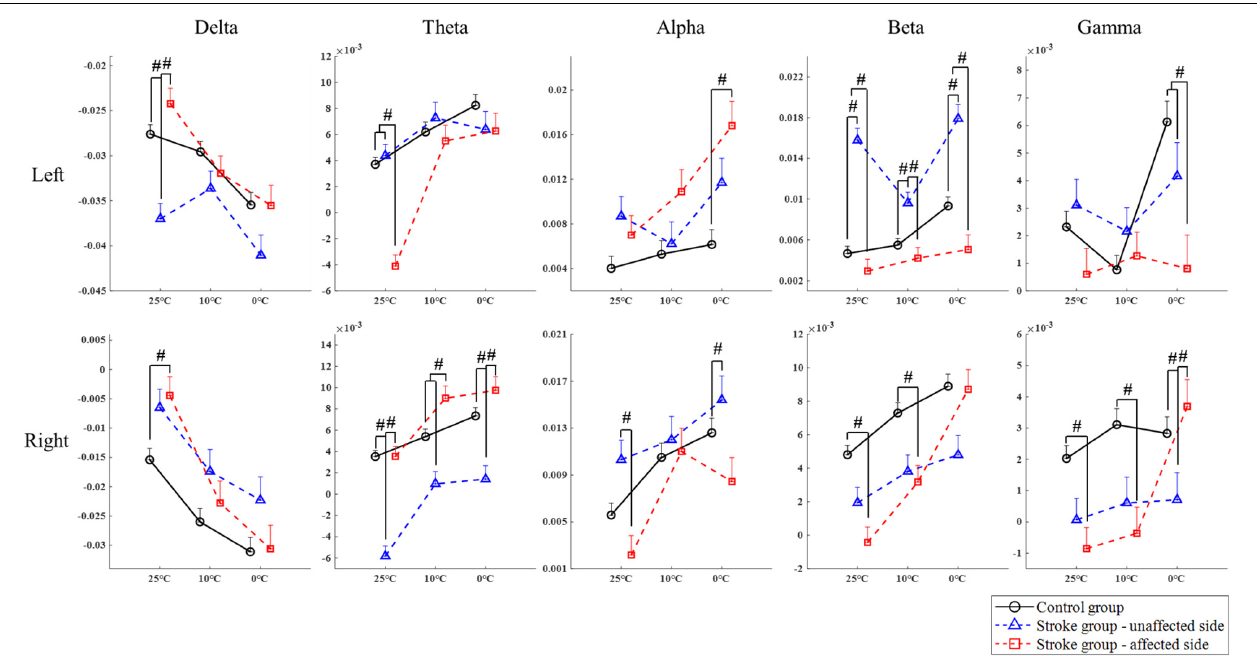
FIGURE 4 | The EEG overall relative spectral power in response to the non-painful cold stimuli on the left and right forearms for each group at the delta, theta, alpha, beta, and gamma band, respectively, presented as mean value with SE (error bar). The significant intergroup differences are indicated by “#” ( P < 0.05, one-way ANOVA with Bonferroni post-hoc tests or Dunnett’s T3 post-hoc